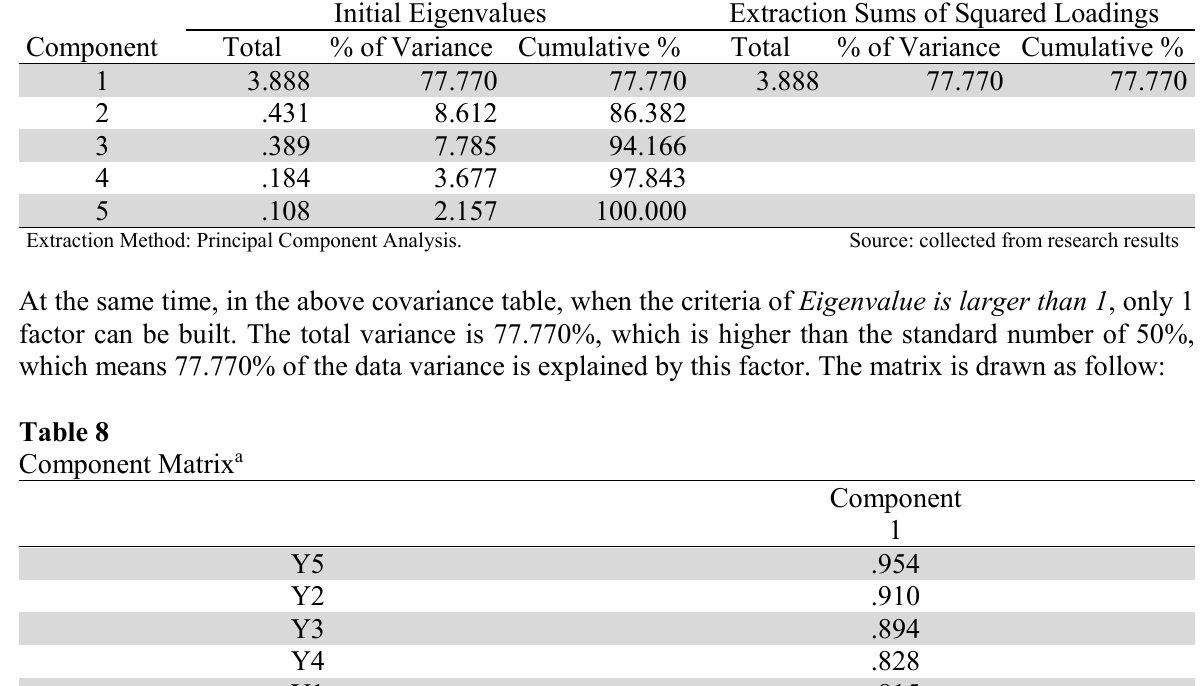
Total Variance Explained Initial Eigenvalues Extraction Sums of Squared Loadings Component Total % of Variance Cumulative %